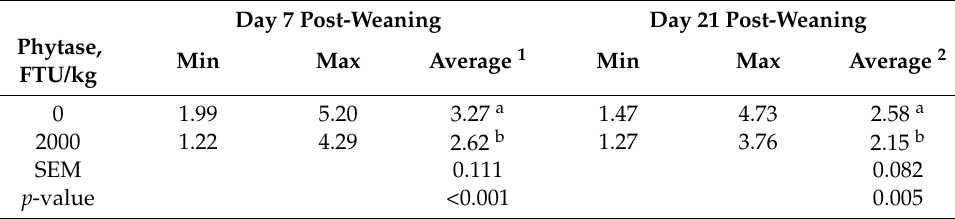
1 Least squares means (LSM) represent the average response of six (0 FTU/kg phytase) and eight (2000 FTU/kg